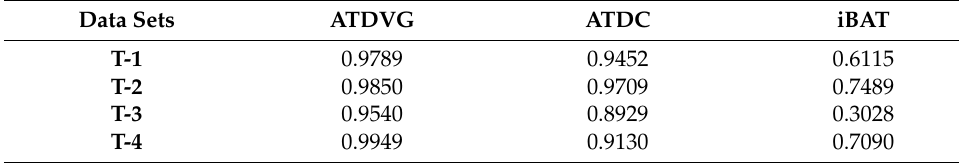
Table 8. Precision